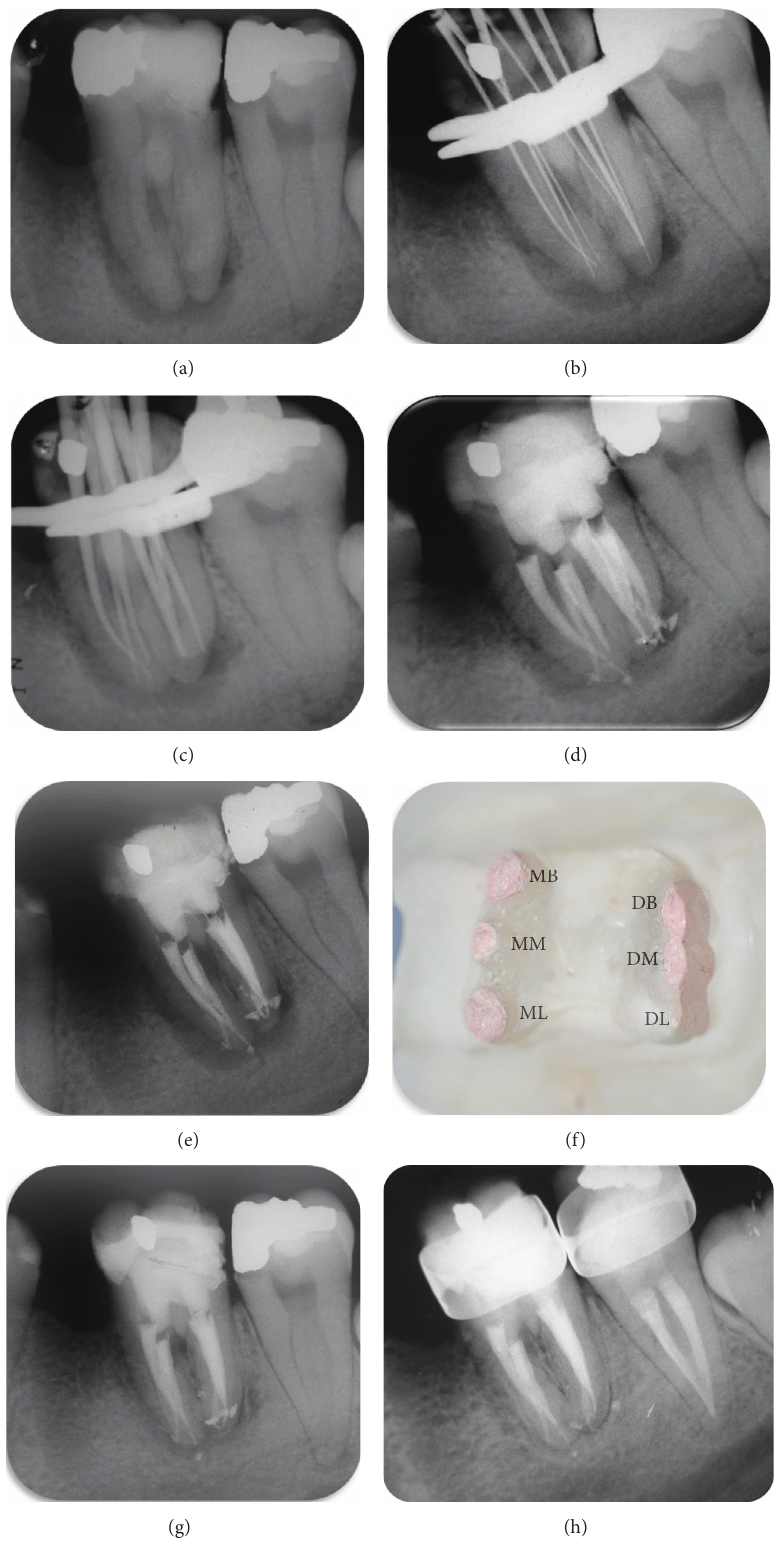
Figure 1: Preoperative radiograph shows normal root canal anatomy and apical lesion (a); radiograph to determine working length (b); radiograph shows gutta-percha cones placed in canals (c); postobturation radiograph shows 6 root canals and independent apical foramina ((d) and (e)); clinical view of pulp chamber after root canal treatment (f); periapical repair 6 (g) and 18 months after treatment